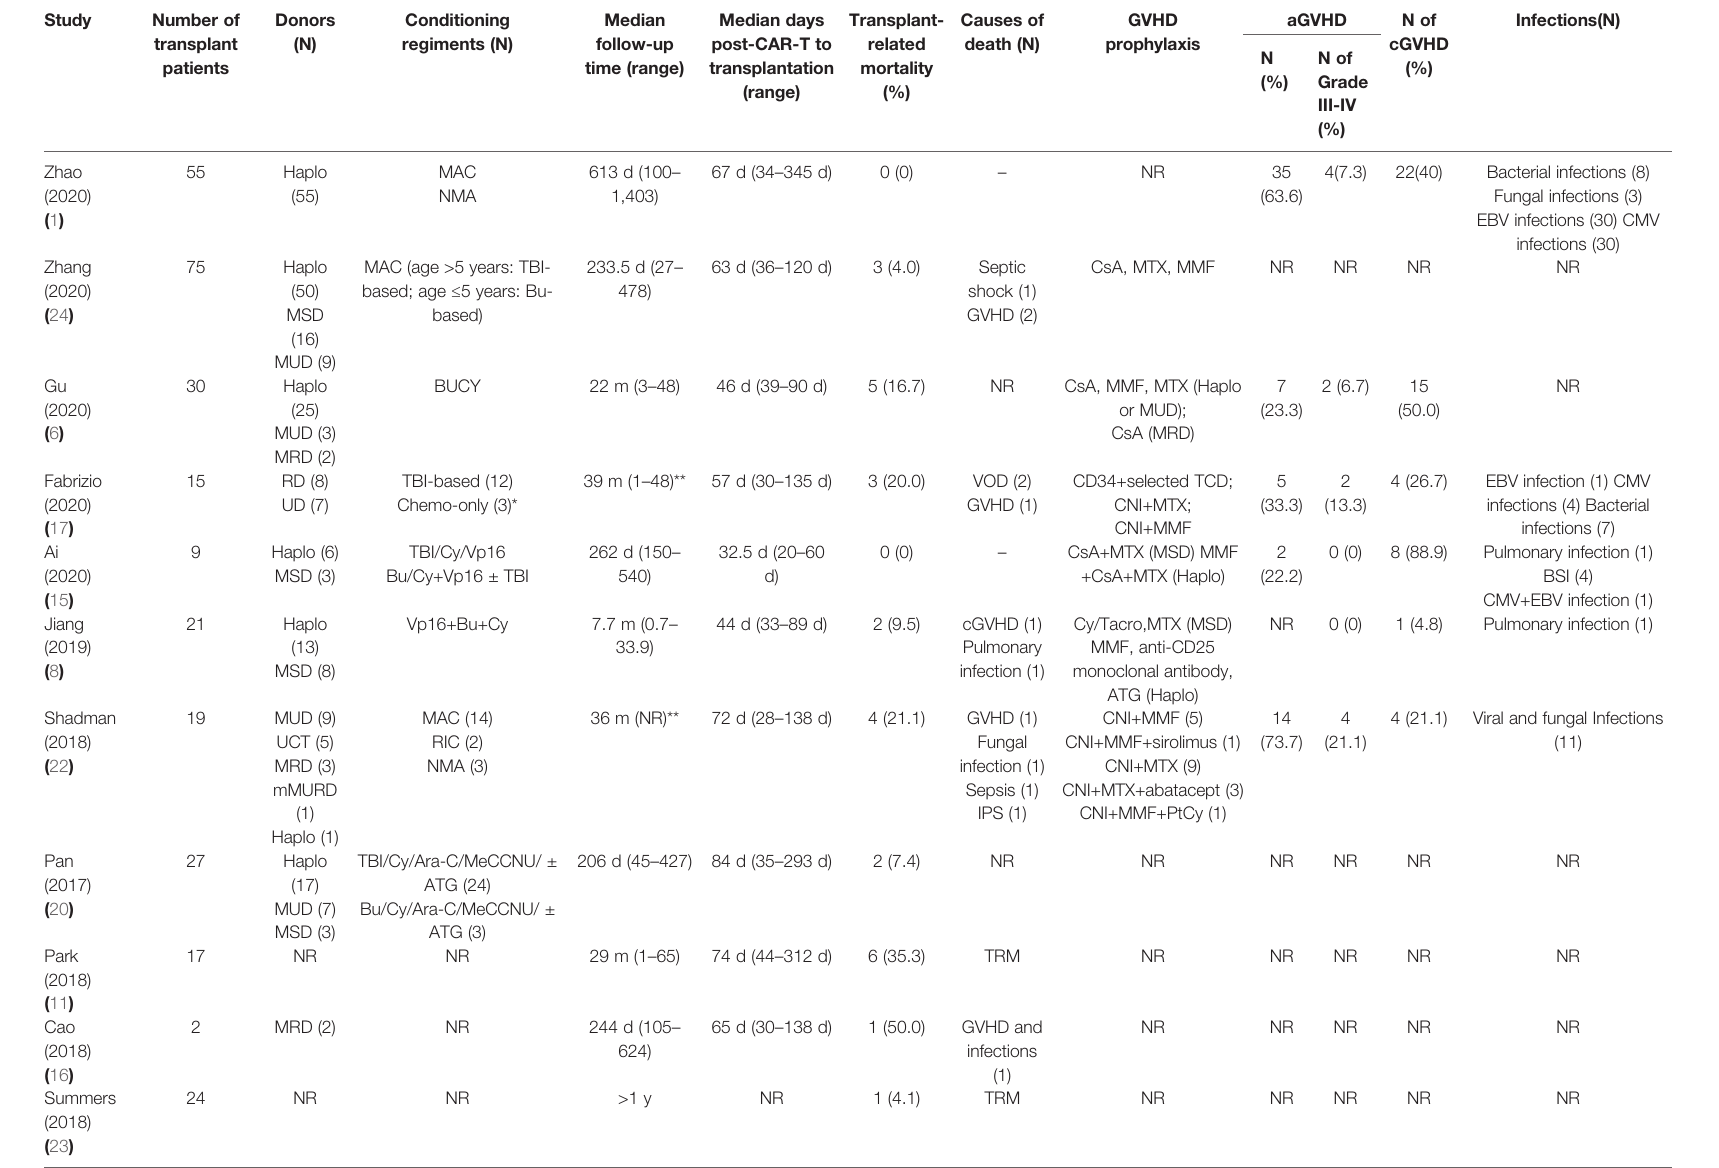
TABLE 2 | Characteristics of the included studies with safety